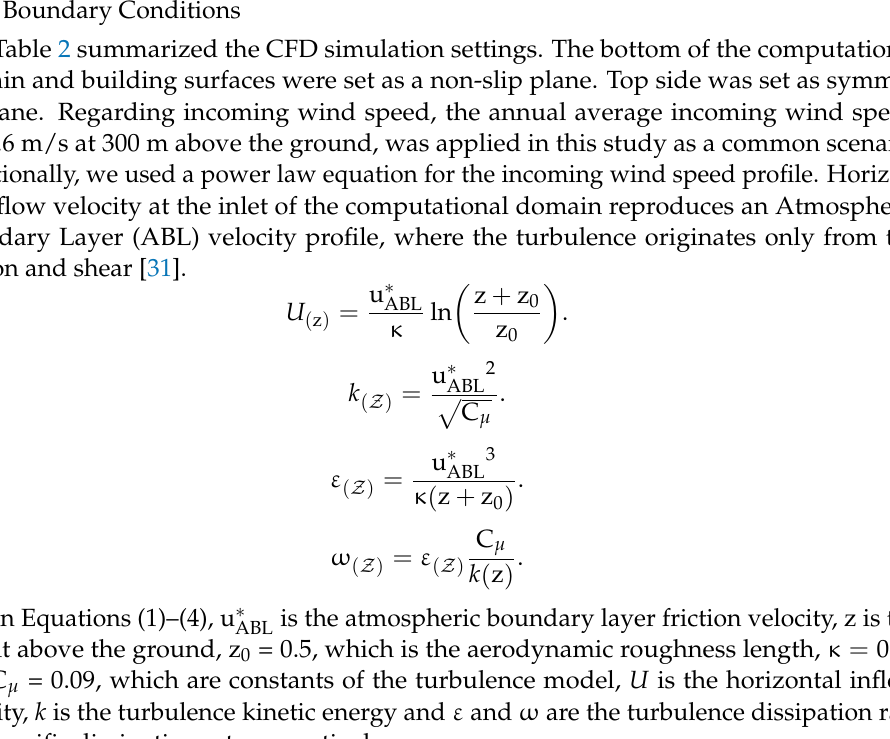
Figure 4. Meshing for Case B as an example (Buildings highlighted as red are the historic shophouses conserved at the Chinatown area).